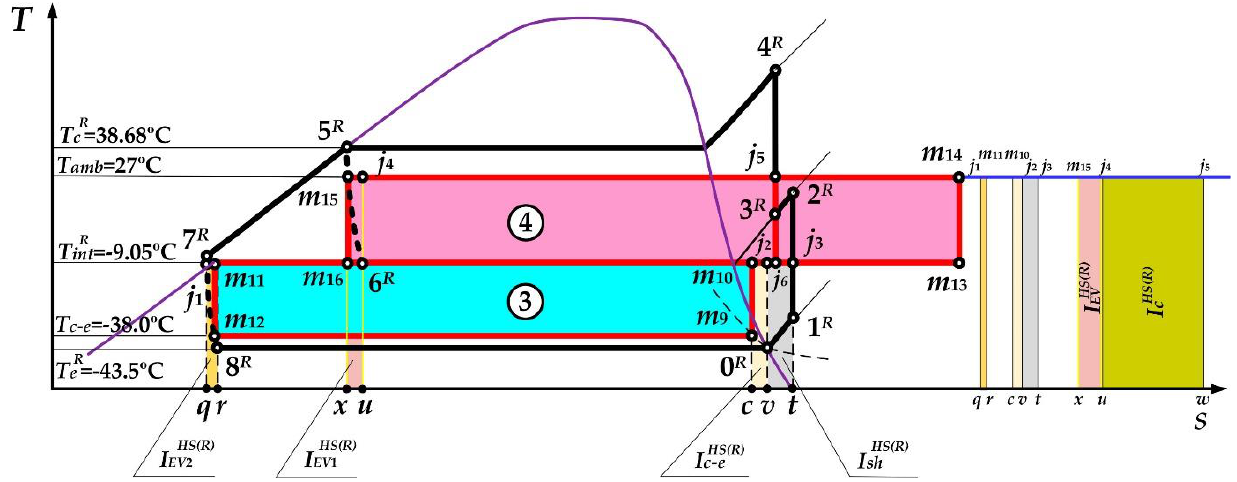
Figure 8. Determination of irreversibilities in the topping stage of the cascade ethylene reliquefaction system. Table 4. The analysis of the topping stage of the cascade system.